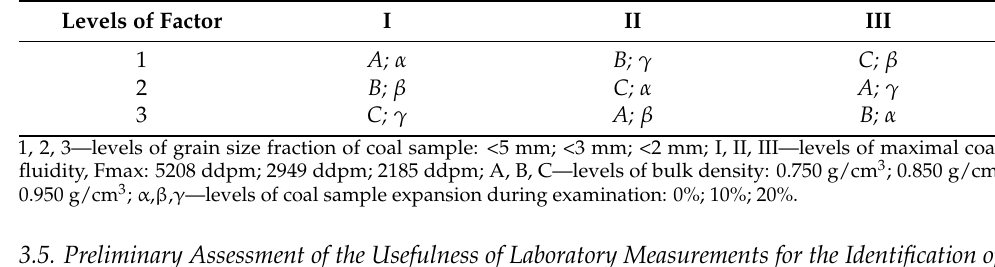
Table 5. Design of the